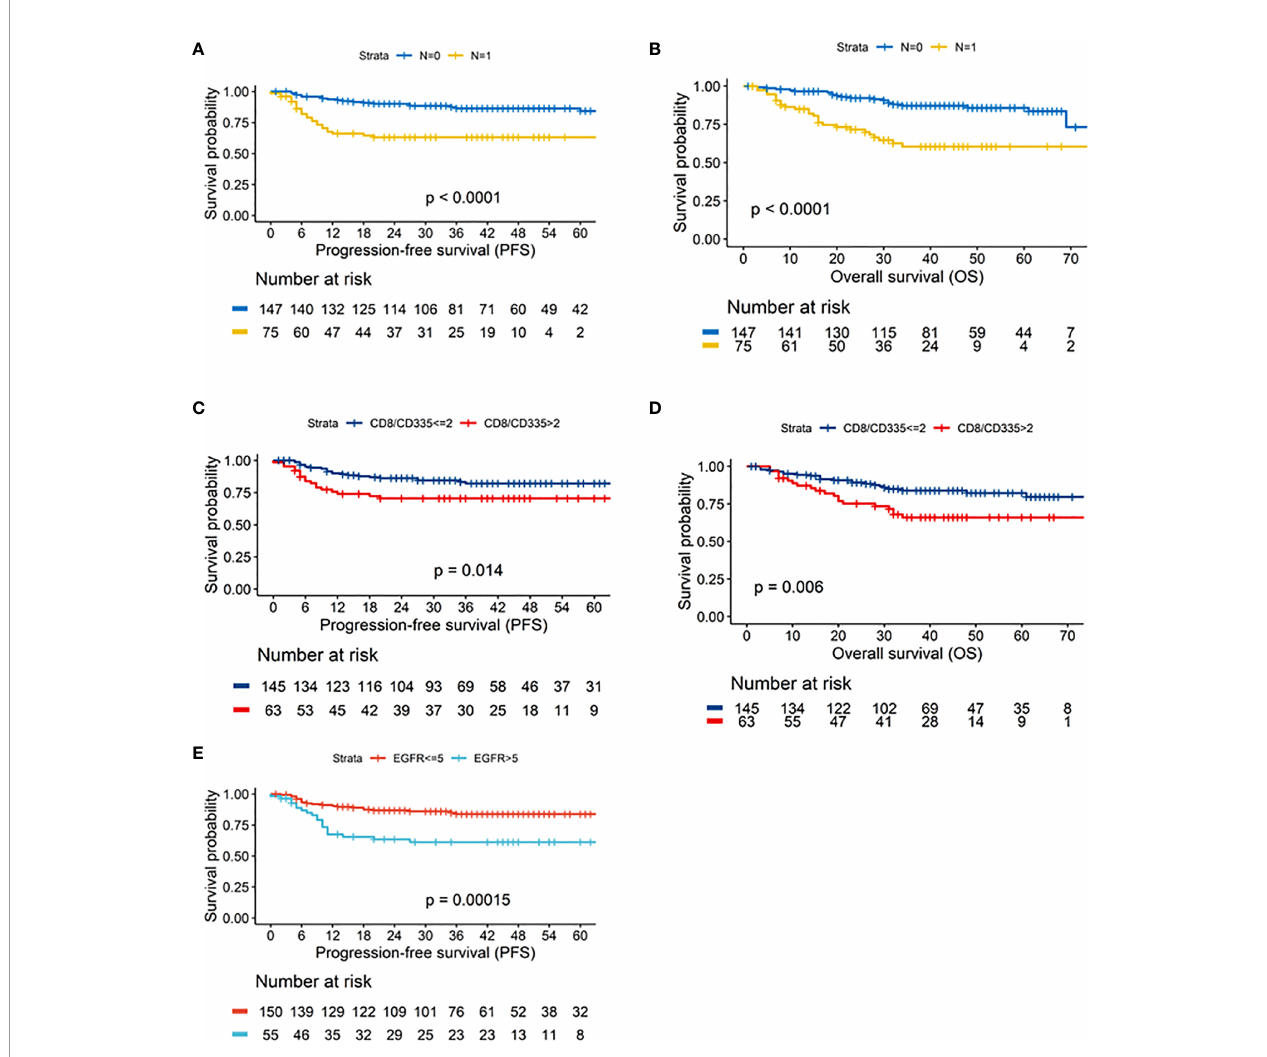
FIGURE 4 | Kaplan-Meier curves depicting the results of the univariate survival analysis for: Neck node status (N0/N1) – (A) . Progression-free survival (PFS) – (B) . overall survival (OS) CD8/CD335 ratio (CD8/CD335 ≤ 2/>2) – (C) . Progression-free survival (PFS) – (D) . overall survival (OS) EGFR status (EGFR ≤ 5/>5 – (E) . Progression-free survival